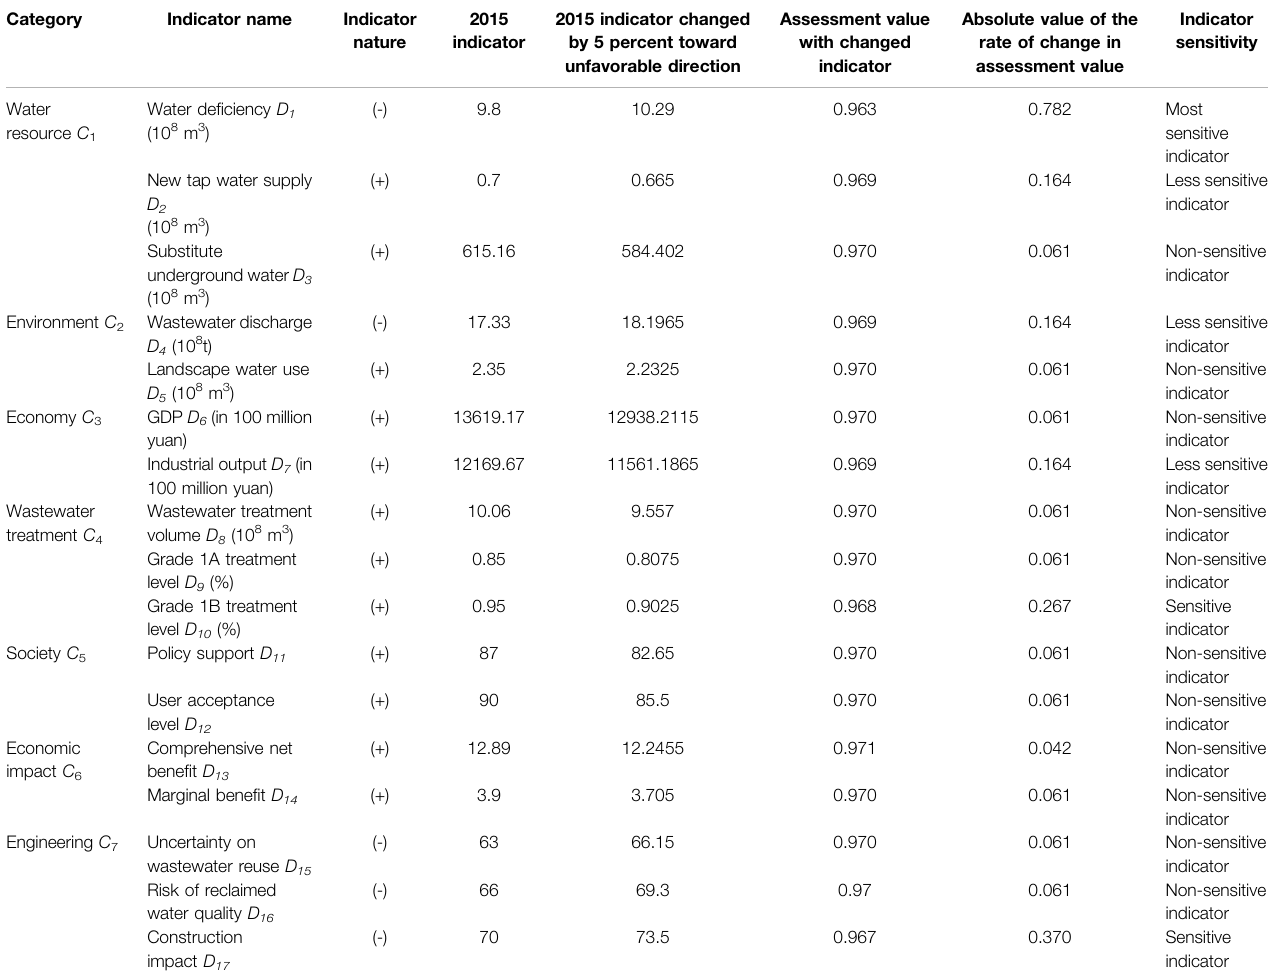
TABLE 8 | Indicator sensitivity analysis